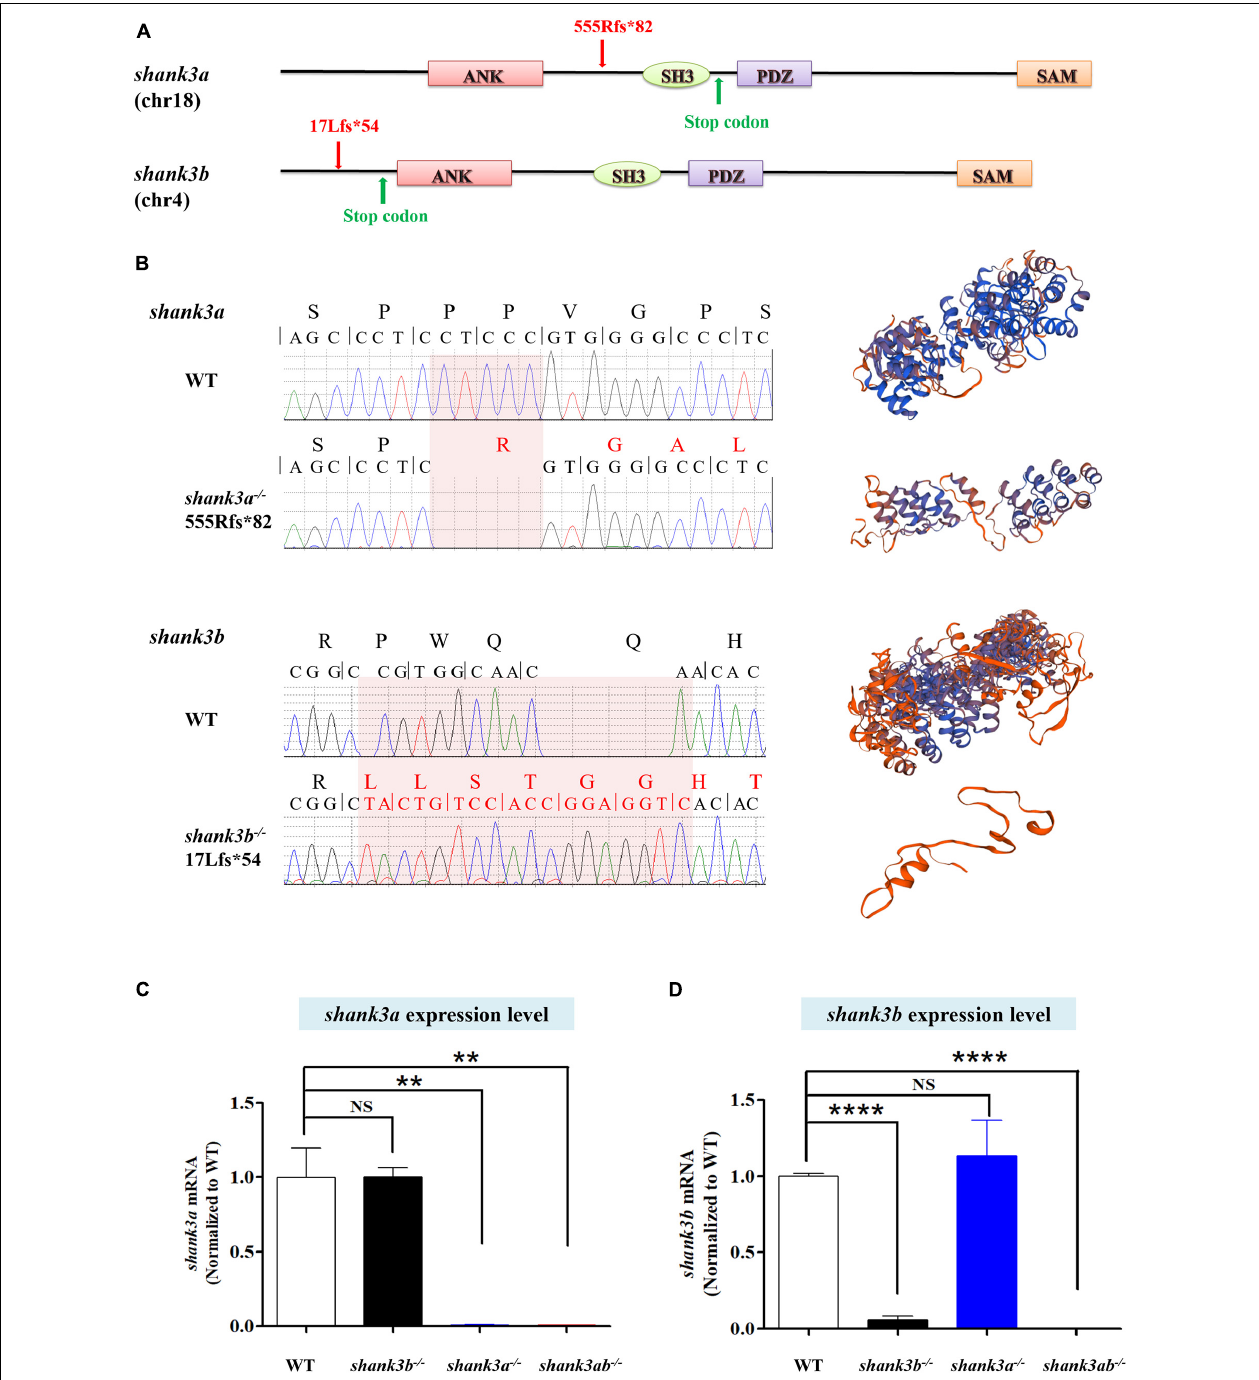
FIGURE 1 | Generation of shank3a and shank3ab mutants in zebrafish by CRISPR-Cas9 gene editing. (A) Structures of zebrafish shank3a and shank3b (Liu et al., 2018) gene and protein domains (ANK, ankyrin repeat domain; SH3, Src homology 3 domain; PDZ, PSD-95/discs large/ZO-1 domain; SAM, sterile alpha motif domain). Exon 9 is the target for CRISPR/Cas9 gene editing in zebrafish shank3a and exon 2 is the target for shank3b. The CRISPR/Cas9 induced frameshift mutations in shank3a (5-base deletion) and in shank3b (5-base deletion and 13-base insertion) which led to the truncation of the protein (Liu et al., 2018). (B) The mutations of shank3a and shank3b (Liu et al., 2018) were verified by Sanger sequencing. The predictions of protein spatial structures were both suggested that shank3a and shank3b proteins were likely to turn into truncated proteins (https://www.swissmodel.expasy.org/interactive/wUdwQQ/models/). (C) Reduced expression level of shank3a mRNA in the brain of shank3a - / - and shank3ab - / - adult (4 mpf) male zebrafish analyzed by RT-qPCR, while shank3b - / - was not affected. (D) Reduced expression level of shank3b mRNA in the brain of shank3b - / - and shank3ab - / - adult (4 mpf) male zebrafish analyzed by RT-qPCR, while shank3a - / - was not affected. Data are shown as mean ± SEM; ** P < 0.01. **** P < 0.0001.